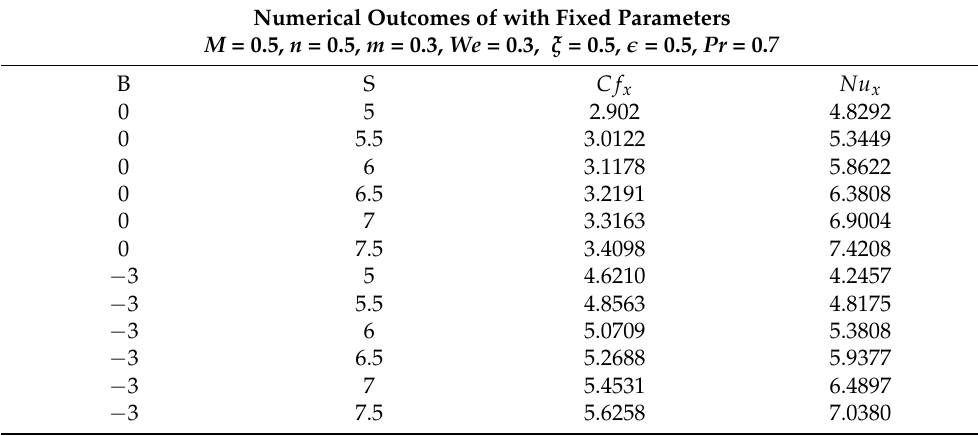
Figure 3. ( a ): Effect of change in Prandtl number on temperature profile, ( b ): Variable viscosity influence on temperature profile, ( c ): Lewis number impact on concentration profile, ( d ): Effect of variable thermal conductivity on temperature profile. Table 1. The numeric results of the shear stress and Nusselt number are under the influence of Stretching ratio and Suction.